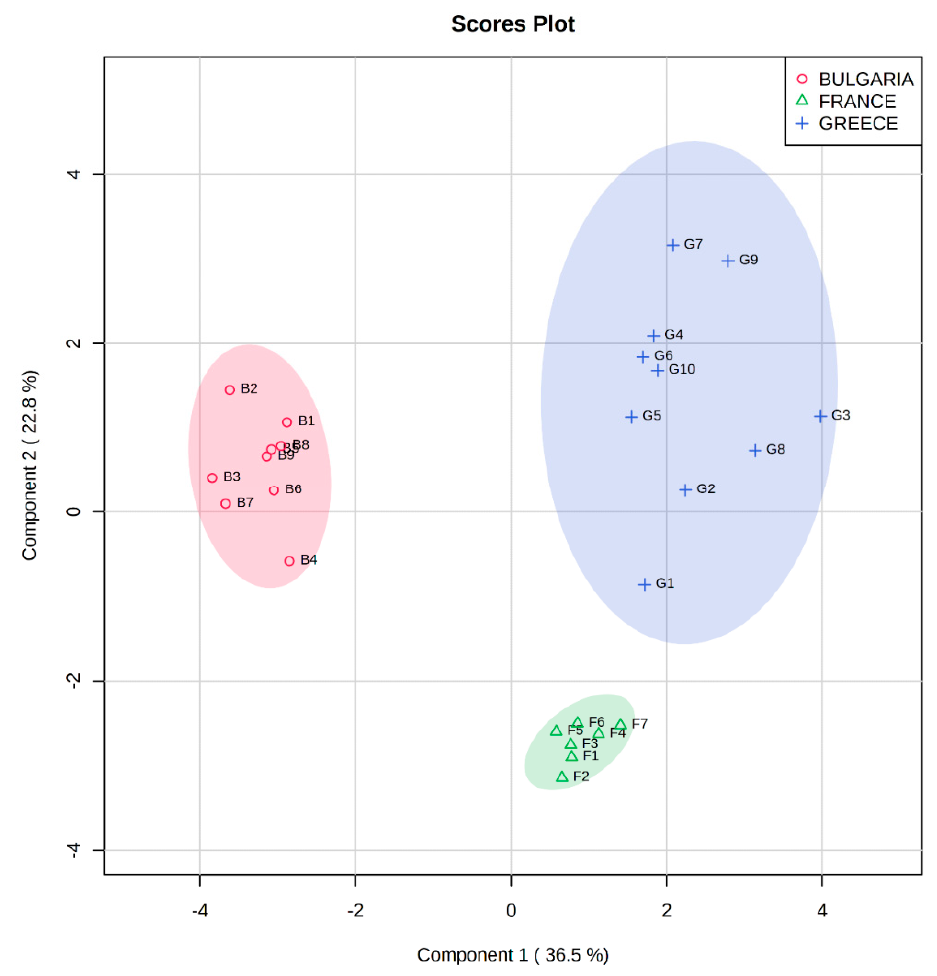
Figure 3. PLS-DA prediction model score plot showing the discrimination of the walnuts originating from Bulgaria (B1 − B9) in red color, France (F1 − F7) in green color, and Greece (G1 − G10) in blue color.